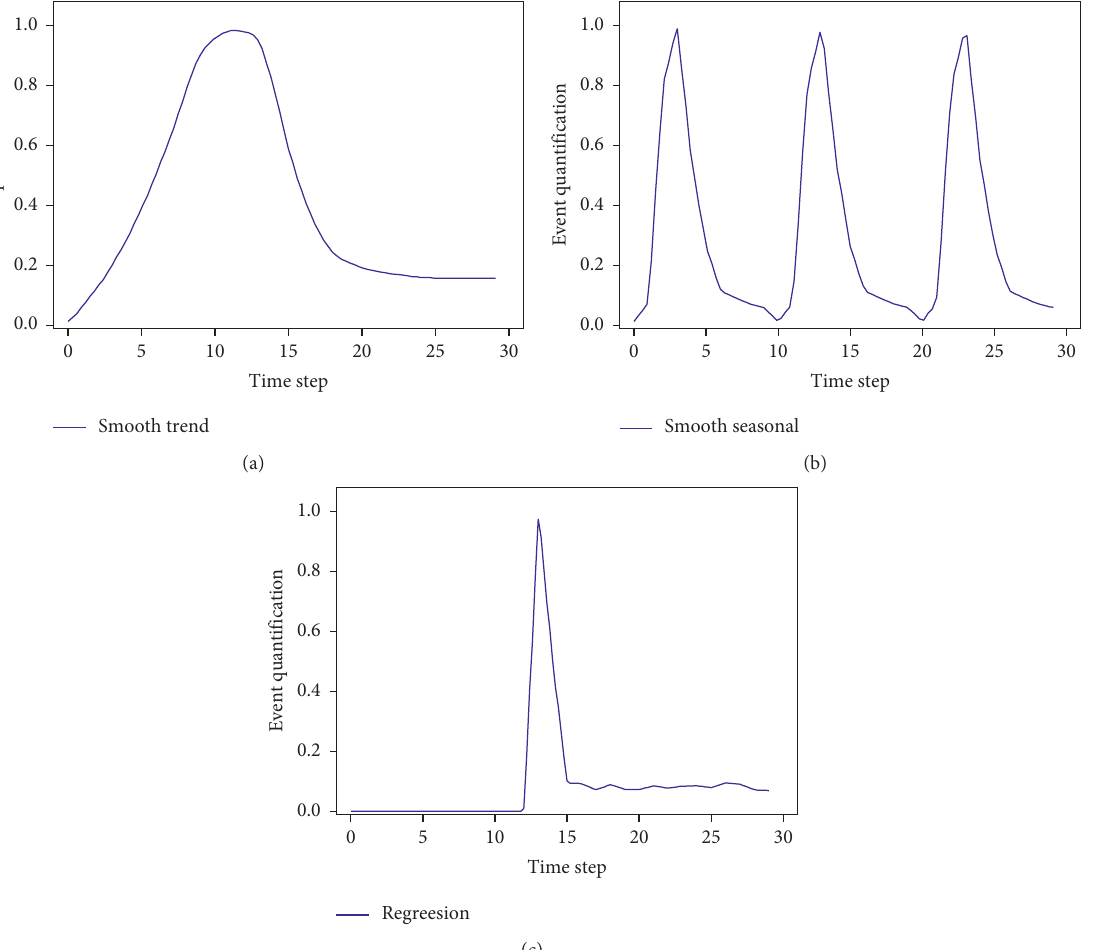
Figure 12: Time-series decomposition of nonstationary event “THAAD” with burst traffic. (a) The trend μ periodicity m e t of the burst flow event. (c) The regression results y t of the burst flow